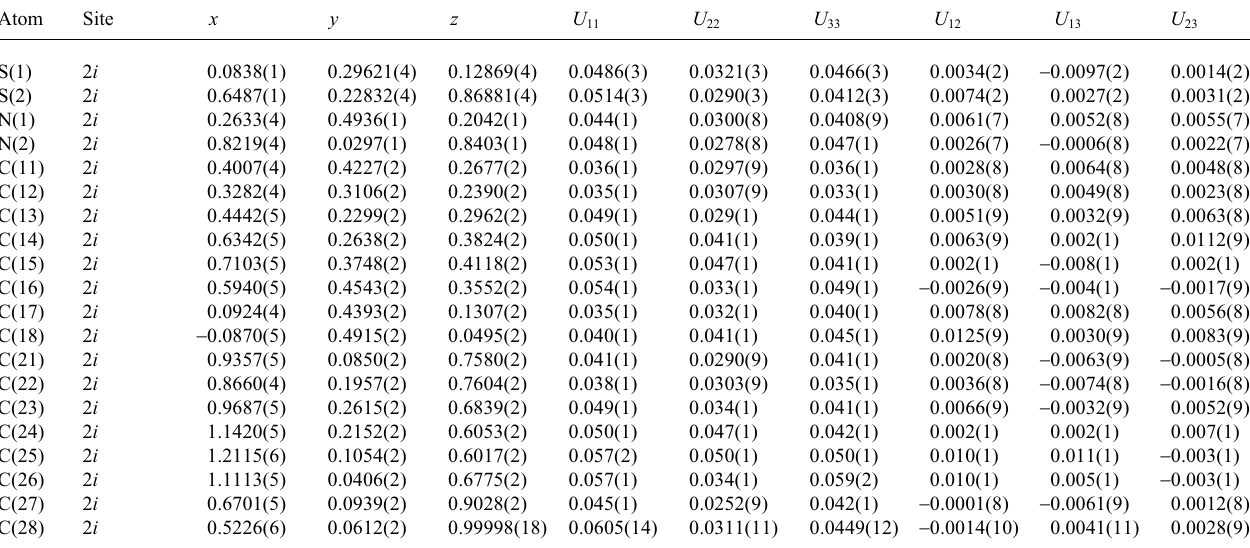
Table 3. Atomic coordinates and displacement parameters (in Å 2 )